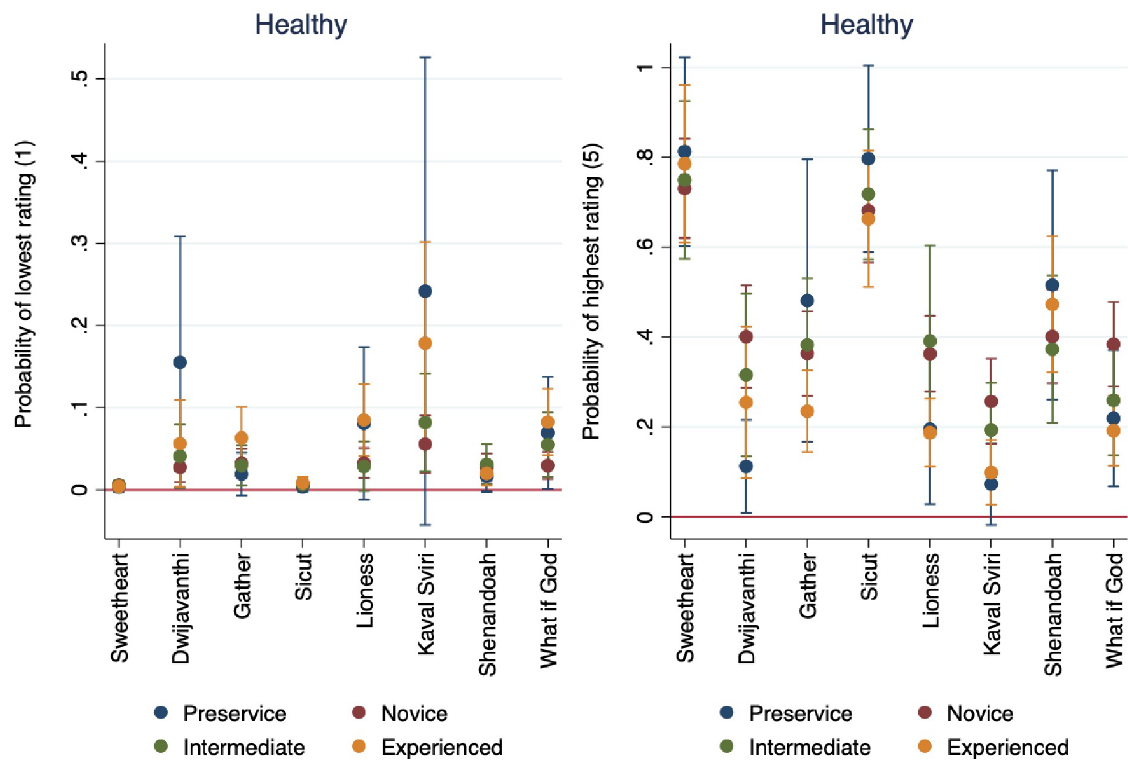
Fig 3. Marginal effects of years’ experience on probability of rating audio samples as healthy, by audio sample.